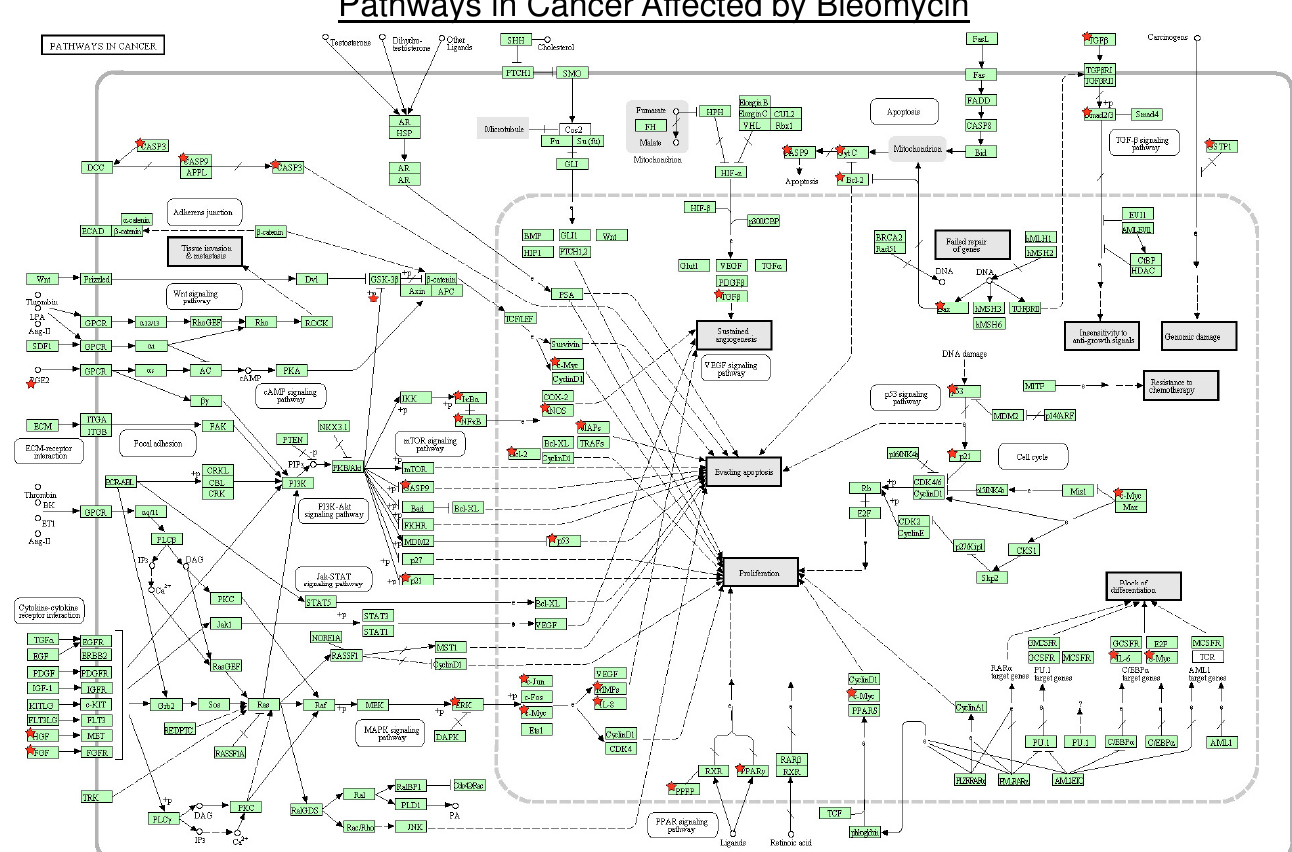
Figure 5. Pathways in Cancer affected by Bleomycin. In order to determine the reactions, genes and gene products that were affected by bleomycin, the Comparative Toxicogenomics Database (Available online: http://ctdbase.org/) was utilised with a requirement of a minimum of three hits. The Database for Annotation, Visualization, and Integrated Discovery (DAVID) tool (Available online: http://david.abcc.ncifcrf.gov/home.jsp) was then used to map these genes onto the Kyoto Encyclopedia of Genes and Genomes (KEGG) Pathways in Cancer map [121]. A step in the Pathways in Cancer KEGG map that was affected by bleomycin is indicated by a red